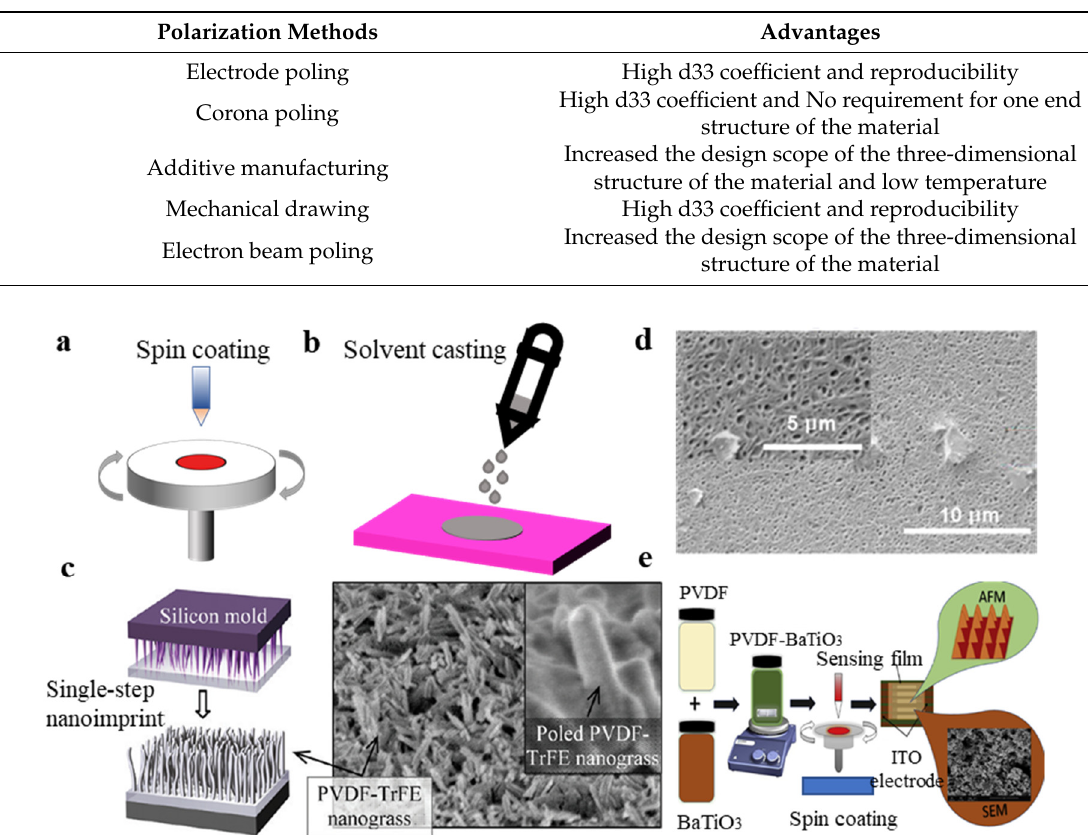
Table 1. The advantages of various polarization